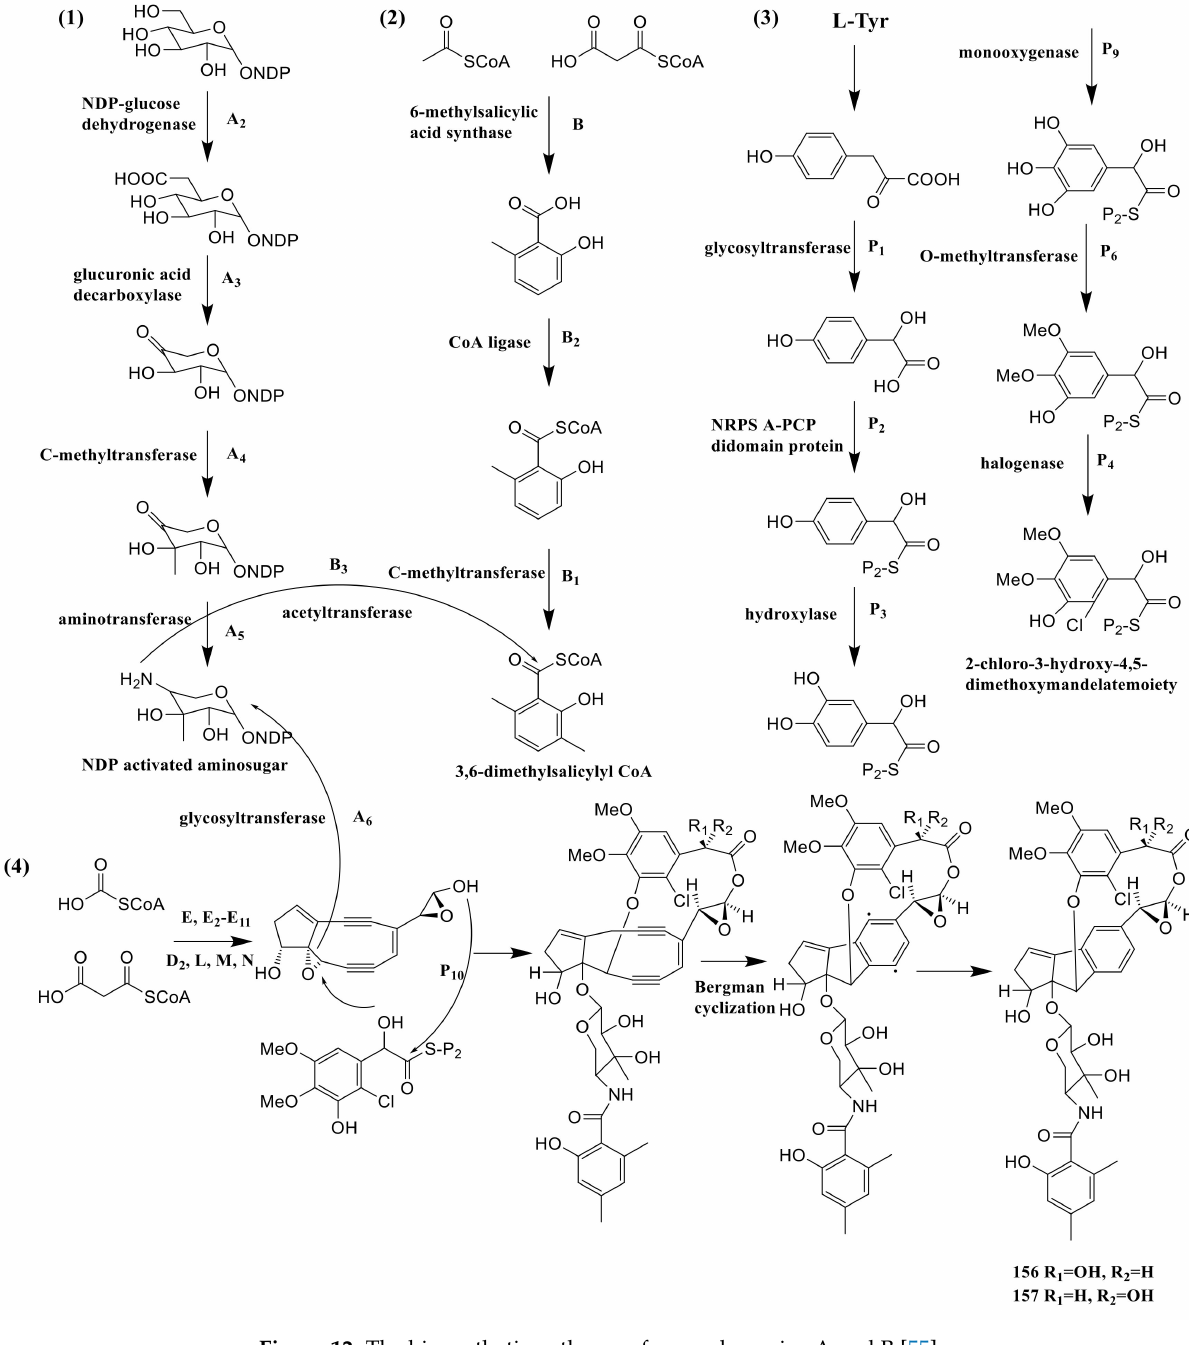
Figure 12. The biosynthetic pathway of amycolamycins A and B